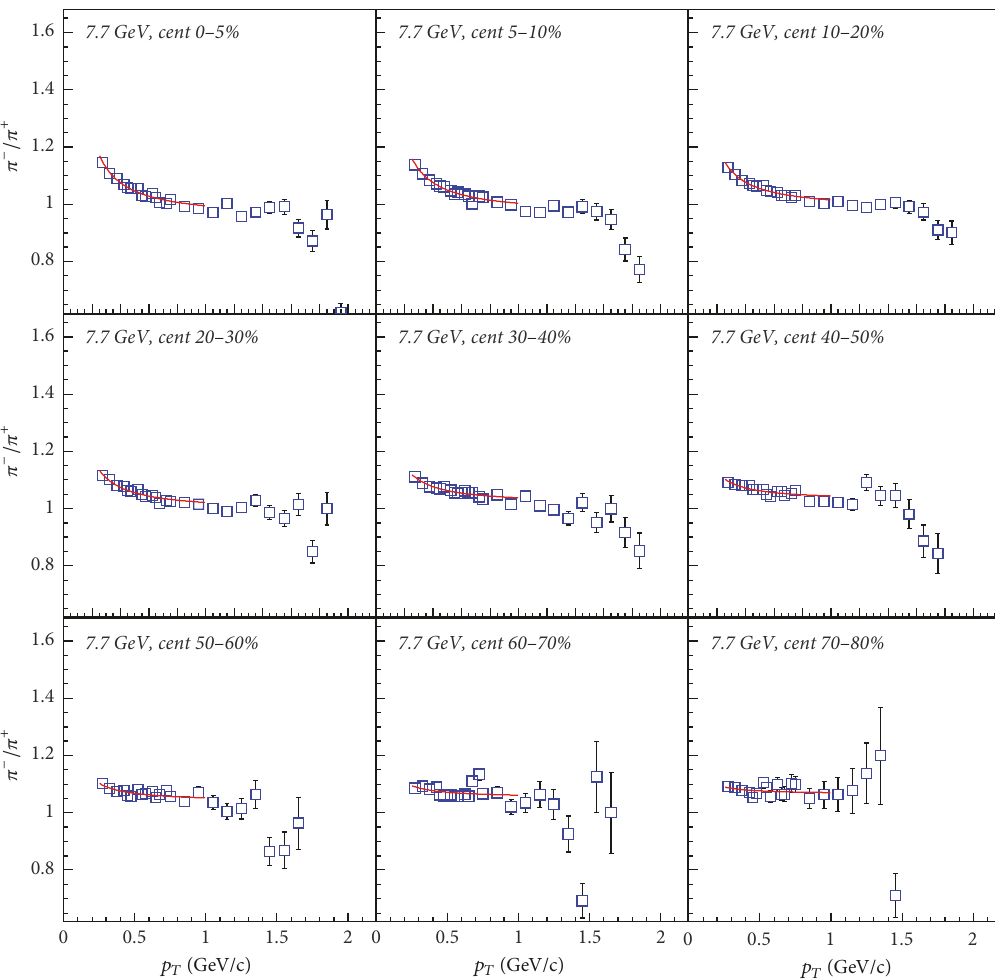
Figure 1: The 𝜋 − /𝜋 + ratios produced in Au+Au collisions at 7.7GeV as a function of transverse momentum. The data are from [14]. The red lines are the fits with